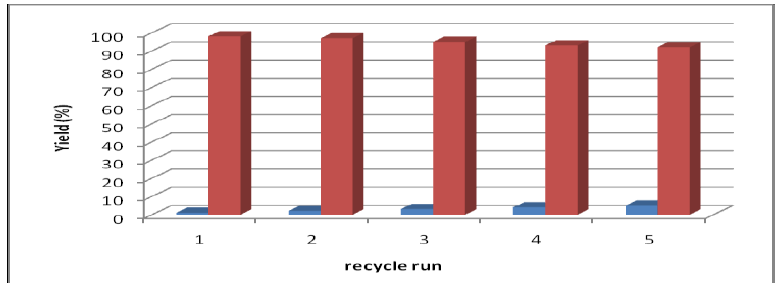
Figure 4. Reusability of nano-Fe